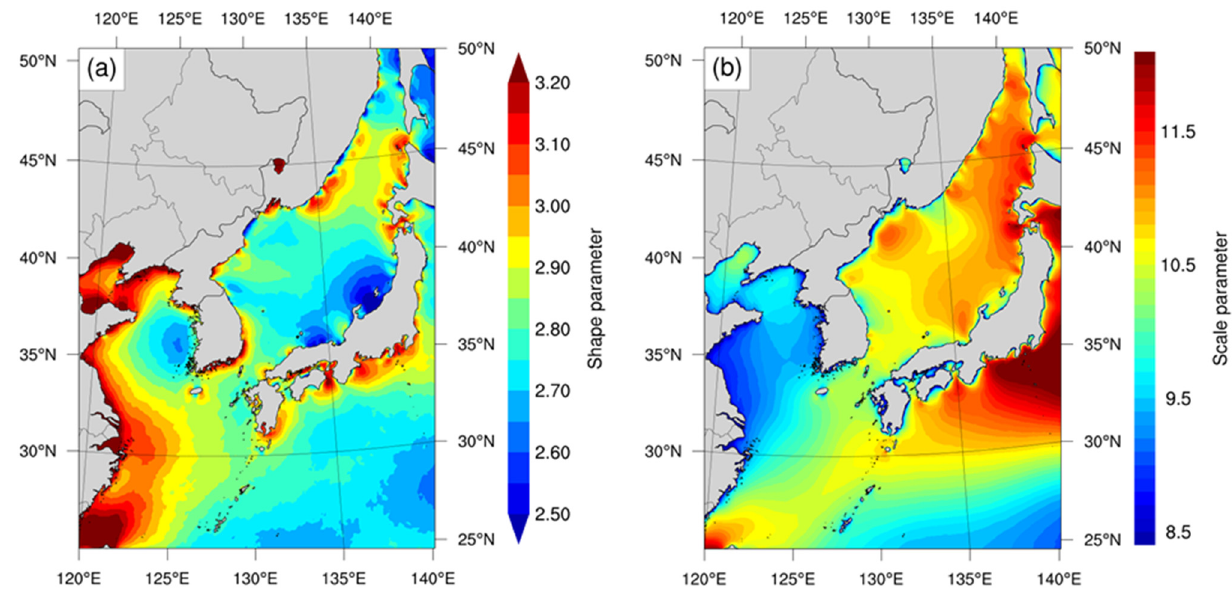
Figure 8. Spatial distribution of the ( a ) shape and ( b ) scale parameter of the Weibull distribution from the daily maximum WRF hindcast wind speed data (1979–2017).